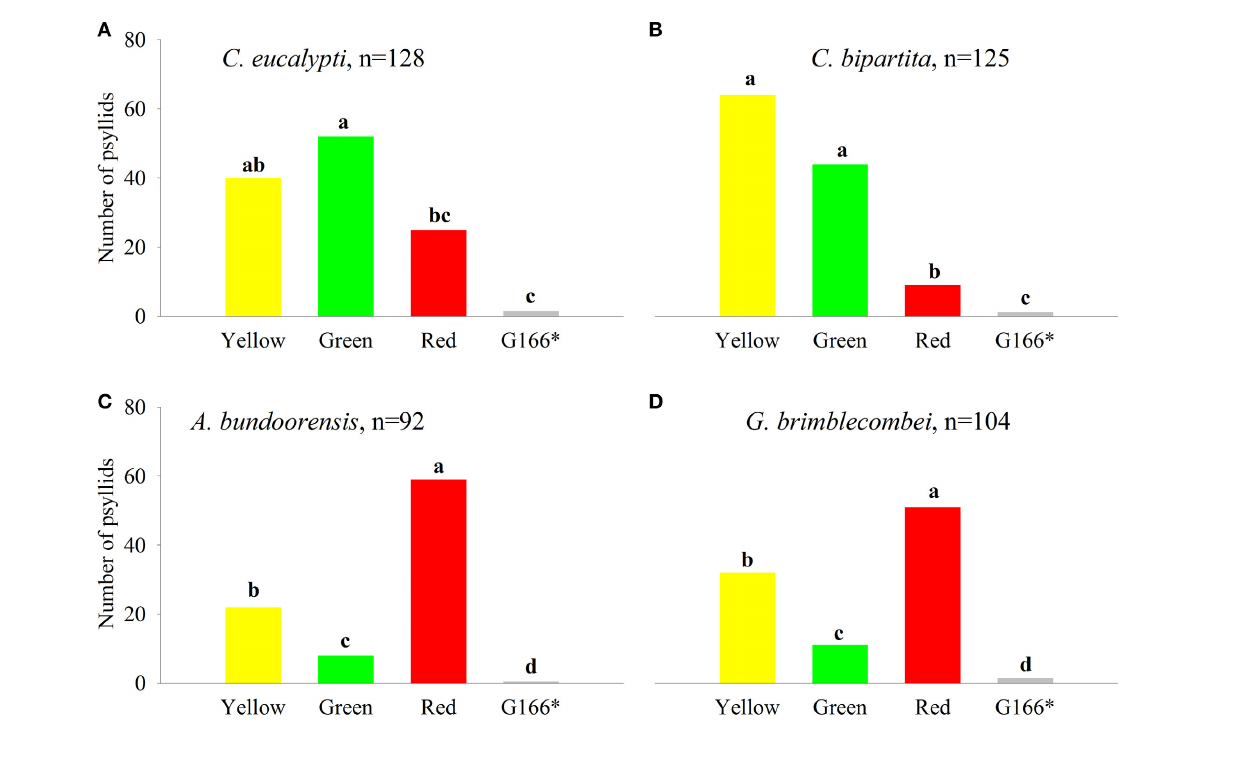
by level of statistical significance. ∗ Number of psyllids was normalized based upon the proportion of the circumference occupied by the background color in the